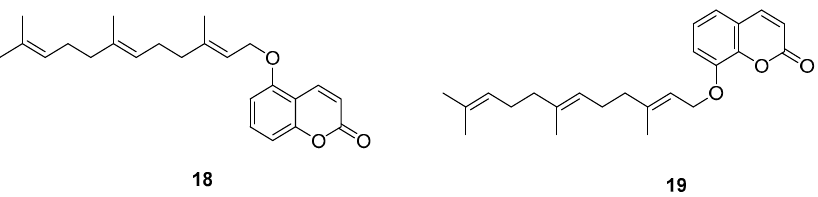
Figure 8. Chemical structure of 5-farnesyloxycoumarin ( 18 ) and 8-farnesyloxycoumarin ( 19 ).